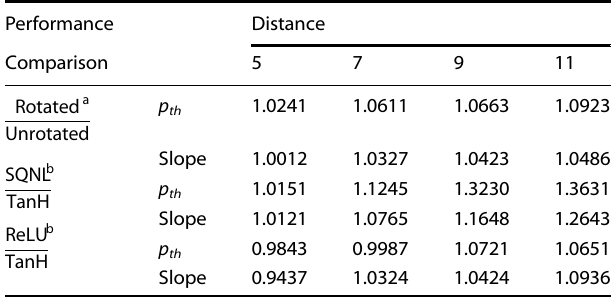
Fig. 9 Schematic diagram of neural network decoder training. a As the number of iterations on the abscissa increases, the training performance of different transfer functions can be seen. b The performance of the SQNL purple graph is the best, but it reaches saturation when the number of iterations reaches 150. Table 1. Training with different transfer functions on a surface code lattice with one-half degree of freedom of rotation, showing performance on different